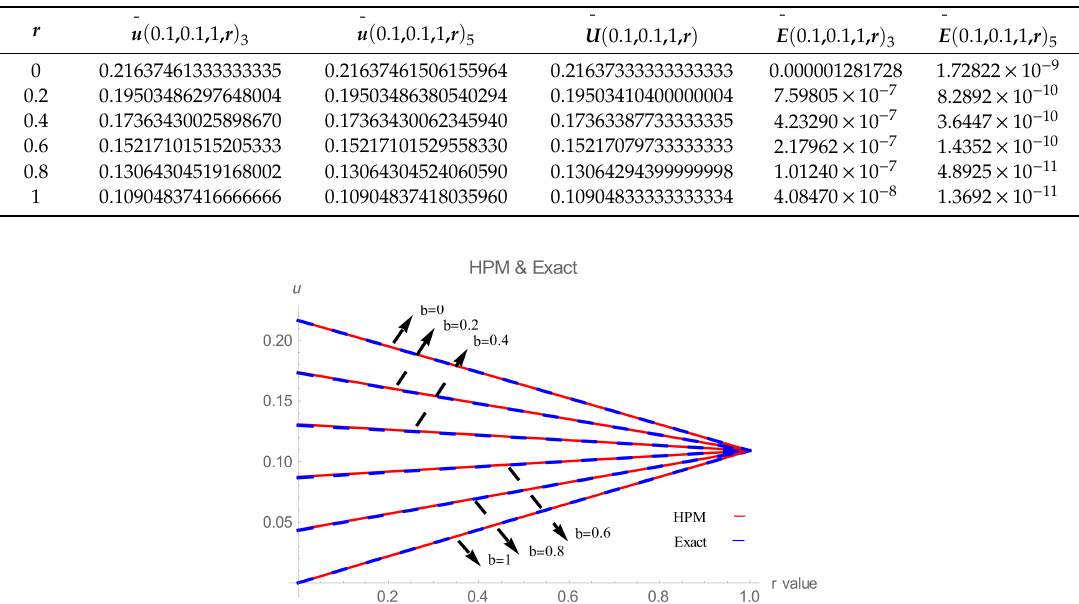
Table 6. Solution and accuracy of third and fifth order double parametric fuzzy HPM solutions for Equation (24) at t , x = 0.1 and b = 1 for all r ∈ [ 0,1 ] .